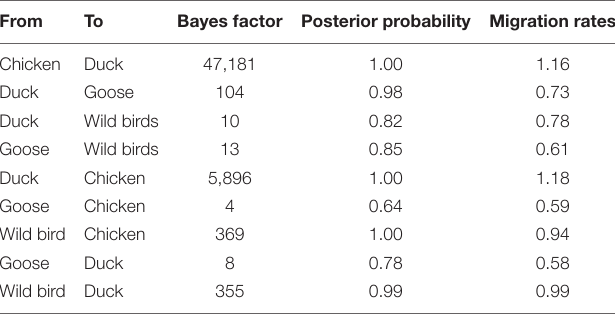
TABLE 3 | Statistically supported host transition of clade 2.3.4.4b H5N8 viruses during 2020–2021 estimated from HA gene